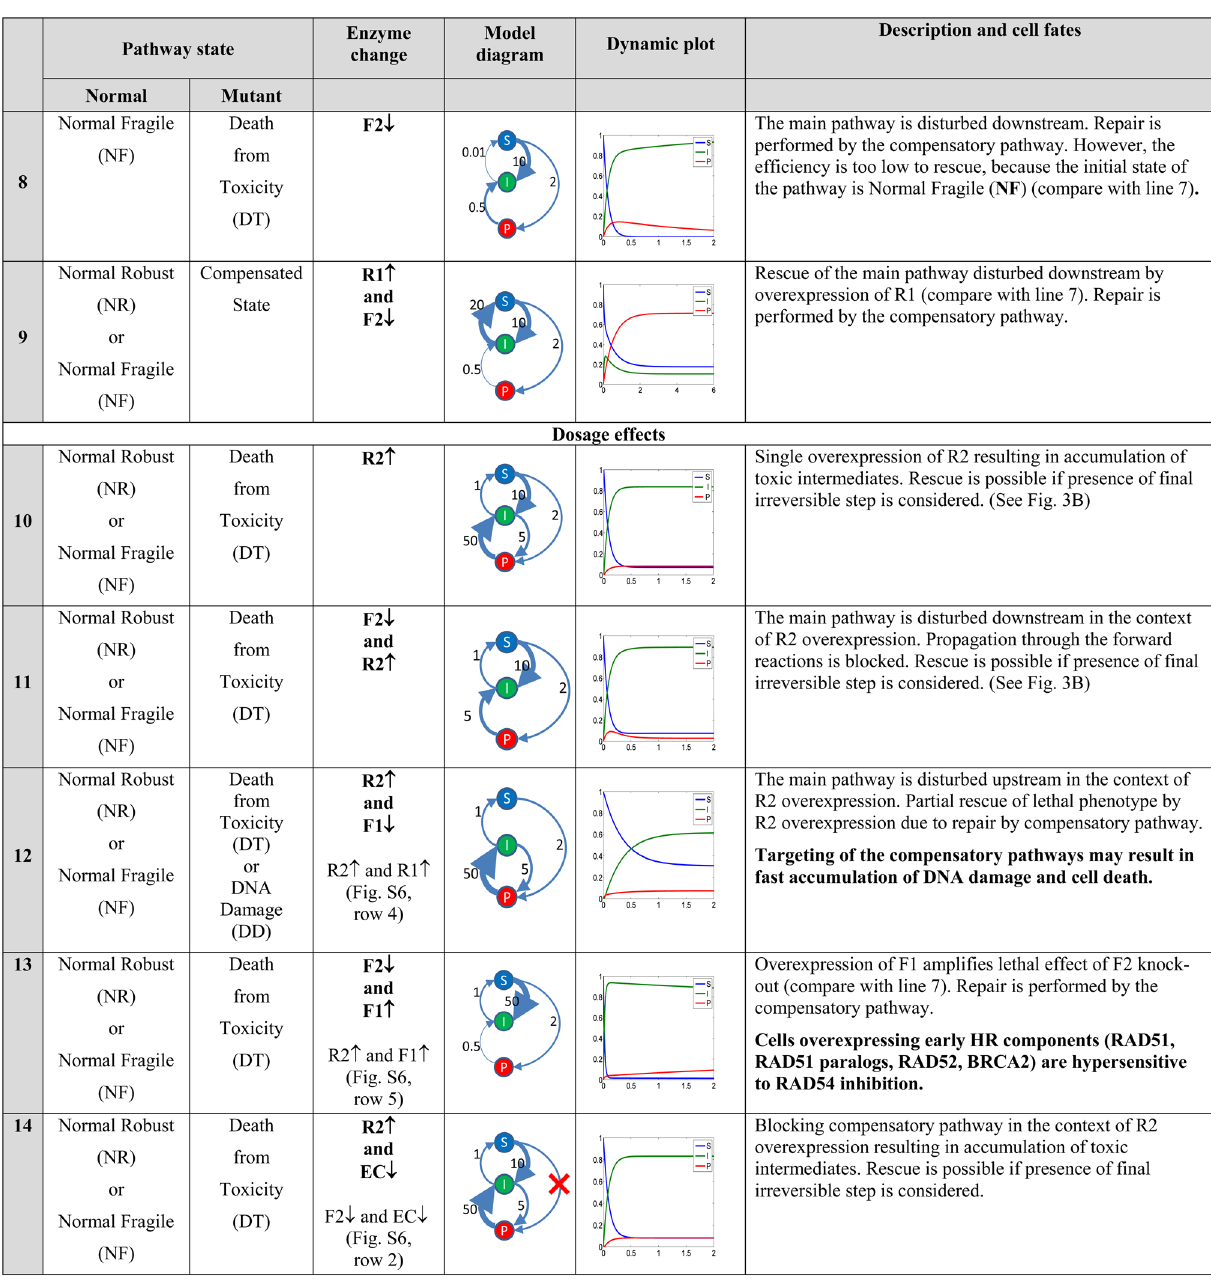
Figure 7. Modeling possible scenarios of single and double synthetic lethal mutations (continued). Pathway steady states depicted as Normal states ( N ) as Normal Robust ( NR ) and Normal Fragile ( NF ); Mutant states ( M ) as compensated state dependent on compensatory pathway EC( C ); death from DNA damage ( DD ) and death from toxicity ( DT ). Dynamic plots show prediction of model for evolution of substrate ( S ), intermediate ( I ) and product ( P ) amounts over time corresponding to the choice of kinetic parameters shown on the Model diagram . ( X-axis )-time, ( Y-axis )-substances level. F1 , F2 , R1 , R2 , and EC refer to the enzymes catalyzing the two forward and two backward reactions as well as the compensatory pathway, respectively (see Figure 3). ( Q )-complete knock-down or mutational loss of function; ( q )-over-expression. A deletion mutant was simulated by setting the corresponding kinetic rate constant to zero. An overexpression mutant was simulated by setting the corresponding kinetic rate constant sufficiently high to have a qualitative effect onto the steady state or the dynamics in the simulations. Some double mutants are not shown due to their triviality (such as F1 Q F2 Q ) or difficulties with interpretation (such as F1 Q R1 Q ). For more modeling scenarios see Figure S5 in Text S1. be taken into consideration (P R I2a/b R EP, Figure 3), slow conversion of all favorable DNA configurations from the futile I « P cycle into the completely repaired DNA state will rescue cells (similar to scenario depicted in Figure 7, row 10). This example is